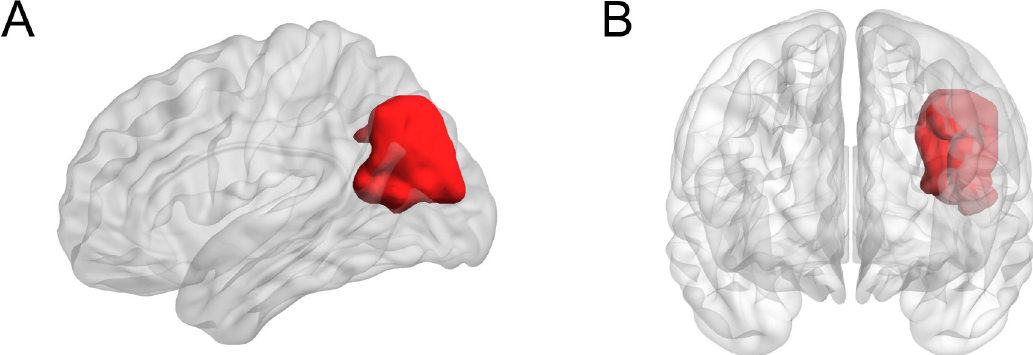
Fig 1. Heading was associated with greater volume of left inferior parietal cortex. (A) Lateral and (B) anterior 3D rendering showing the left inferior parietal cortex in red.